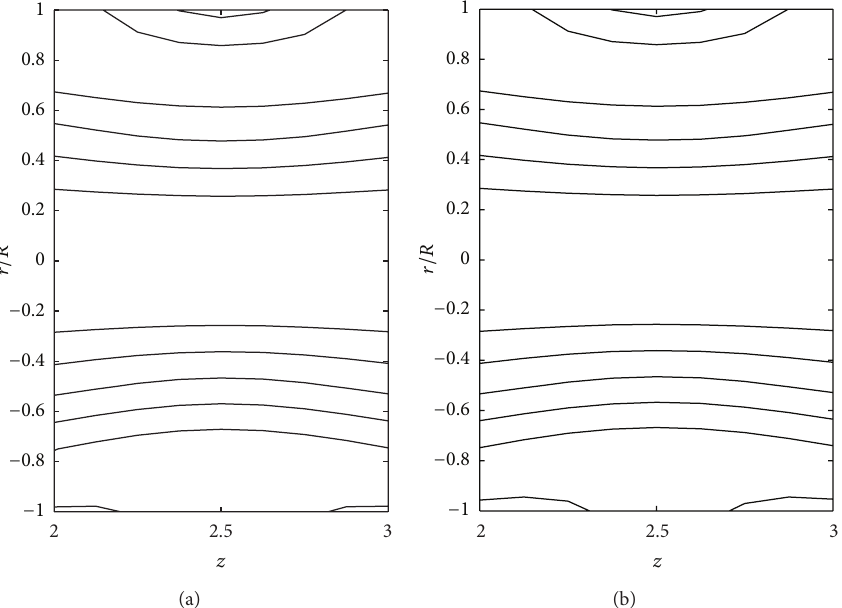
Figure 16: Stream lines for different values of 𝑘 : (a) 𝑘 = 1 and (b) 𝑘 = 1.2 taking 𝛿 1 = 0.2 , 𝜁 = 0.01 , 𝑛 = 0.8 , 𝑘 = 1.4 , and 𝜏 𝑦 = 0.1 in the stenotic region.